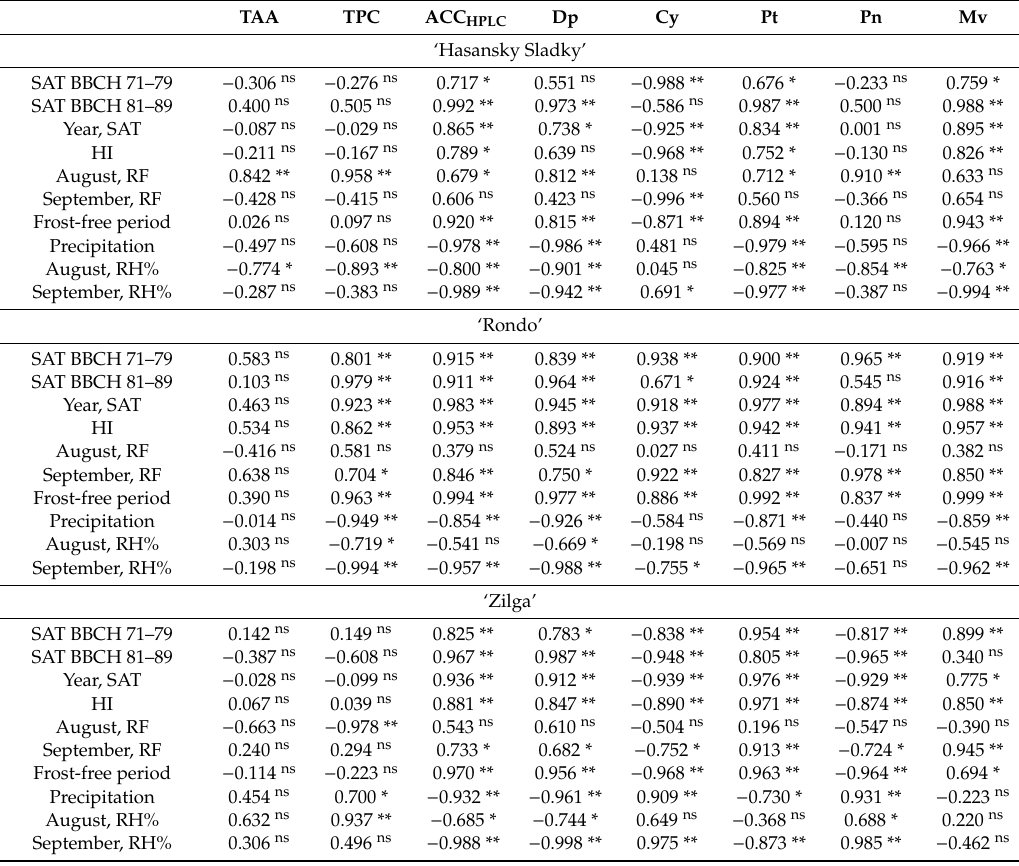
Table 7. Correlations between phenolic compounds and climatic data for grape cultivars ‘Hasansky Sladky’, ‘Rondo’, and ‘Zilga’ (2016–2018) in field